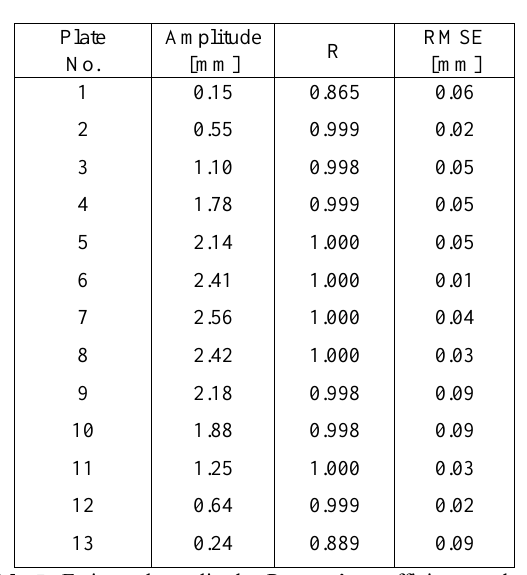
Table 5. Estimated amplitude, Pearson’s coefficient, and root mean squared error for all plates using large resolution burst